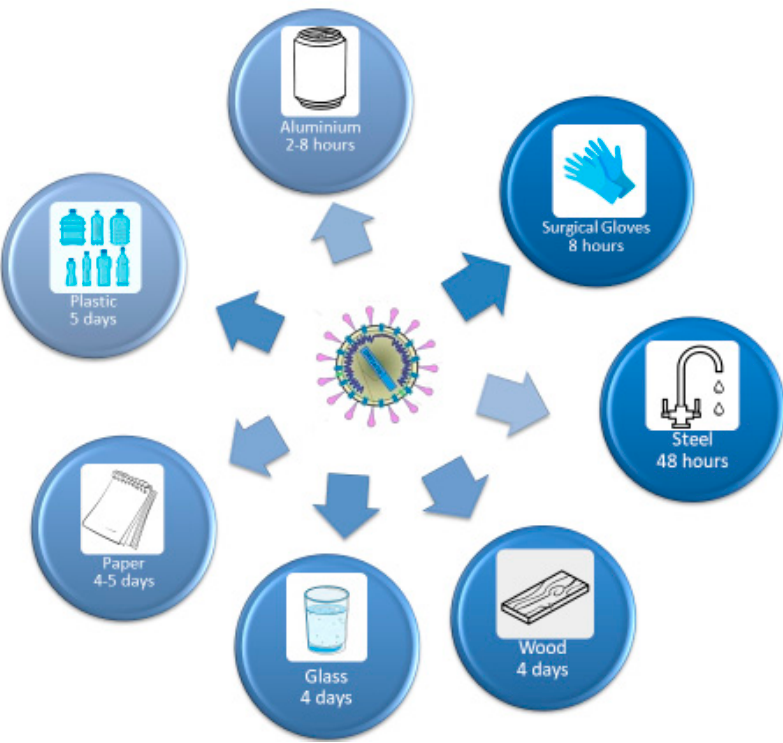
Figure 12. The persistence of SARS-CoV2 on different surfaces (figure drawn by Giovanna Dipalma) .